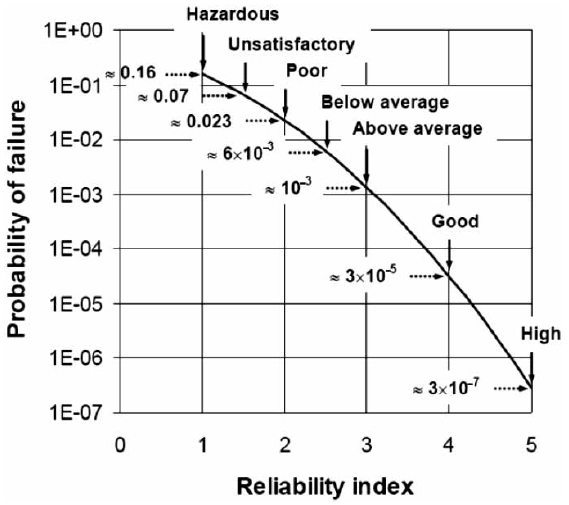
Fig. 2. Assessment of dam safety levels with the